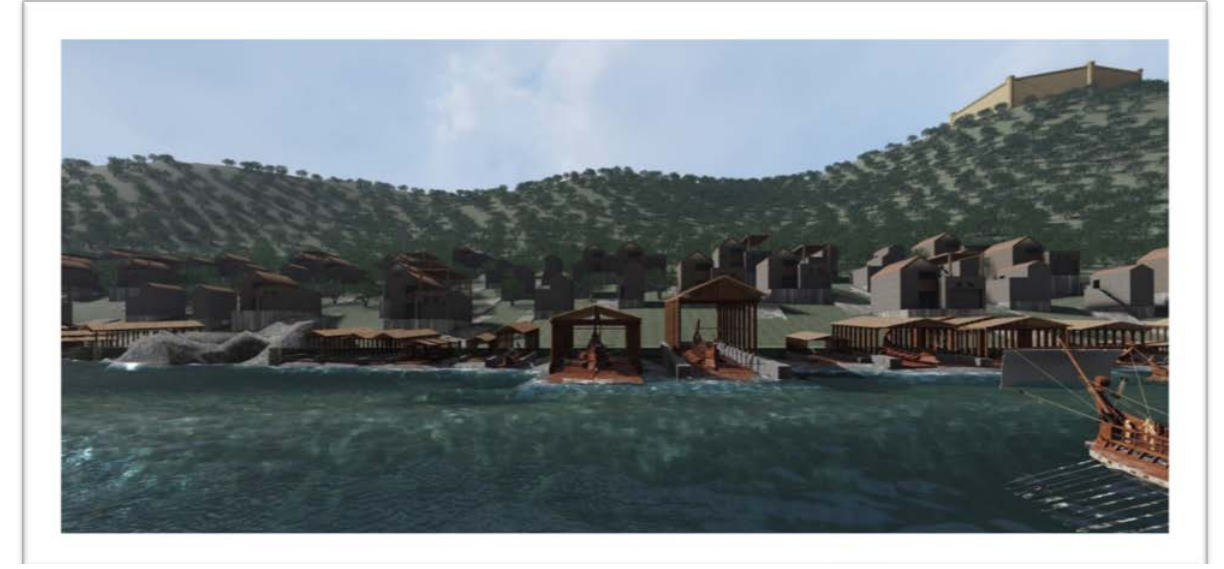
Figure 12 Shipsheds/slipways and workshops/ateliers